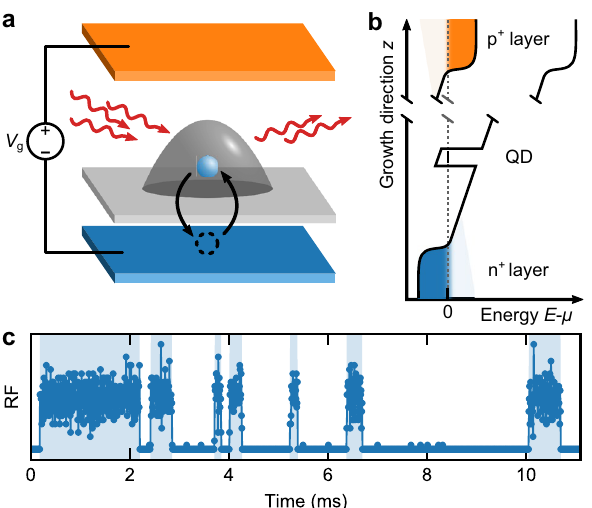
Figure 1. Sample structure and random telegraph signal. ( a ) The QD is resonantly-excited by a tuneable laser and embedded in a pin-diode structure. Its charge state can be tuned by applying a voltage V g to the diode that sets the ground state of the QD in resonance with the chemical potential of the n + -doped back contact. ( b ) Schematic illustration of the conduction and valence band edge in respect to the chemical potential µ (dashed line). ( c ) The resonance fluorescence signal of the QD is switching between “on” and “off” due to electrons tunneling between the QD and the charge